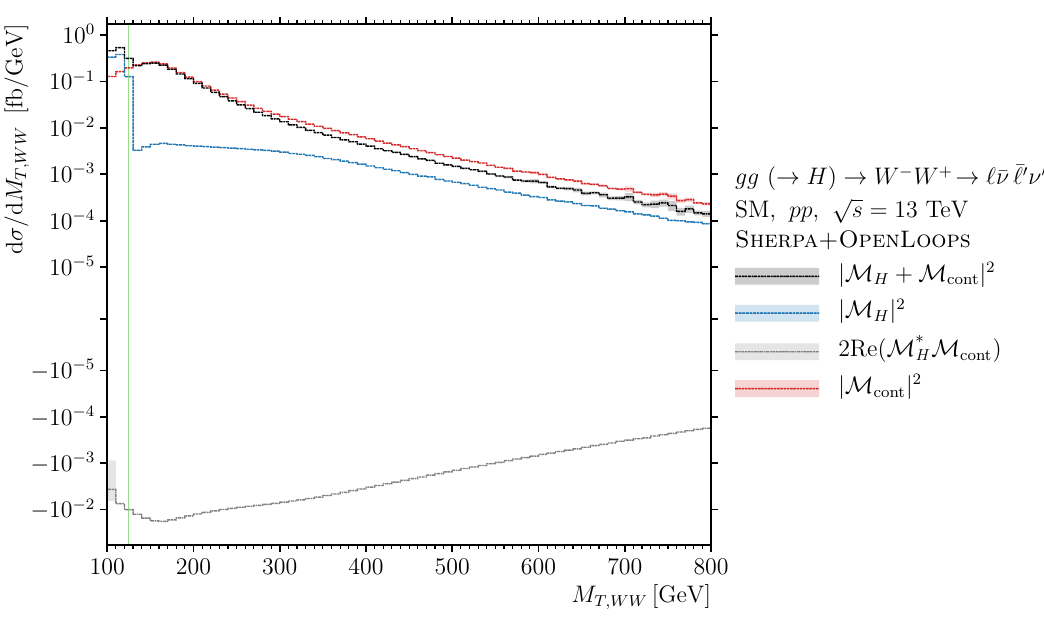
+ (cid:27) ¯ ν ¯ (cid:27) (cid:30) ν (cid:30) in the SM →